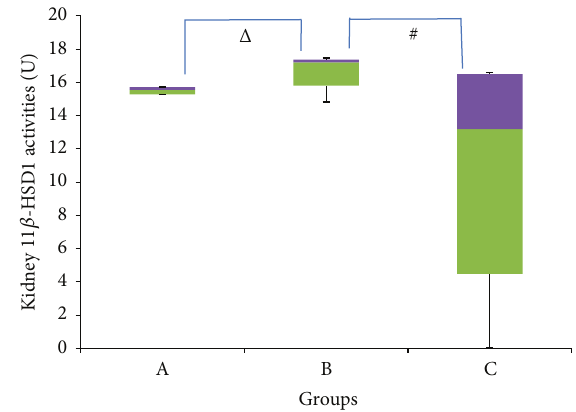
Figure 9: 11 𝛽 -HSD 1 activities in the kidney of rats in group A, B, and C at the end of the four-week treatment period. # Significant difference ( 𝑃 < 0.05 ) between denoted groups. Δ Weakly significant difference ( 𝑃 = 0.05 ) between denoted groups. Group A: control (HSD/HFD); group B: stress+HSD/HFD; group C: stress+GA+HSD/HFD. Abbreviations: GA: glycyrrhizic acid, HSD: high-sucrose diet, and HFD: high-fat diet.